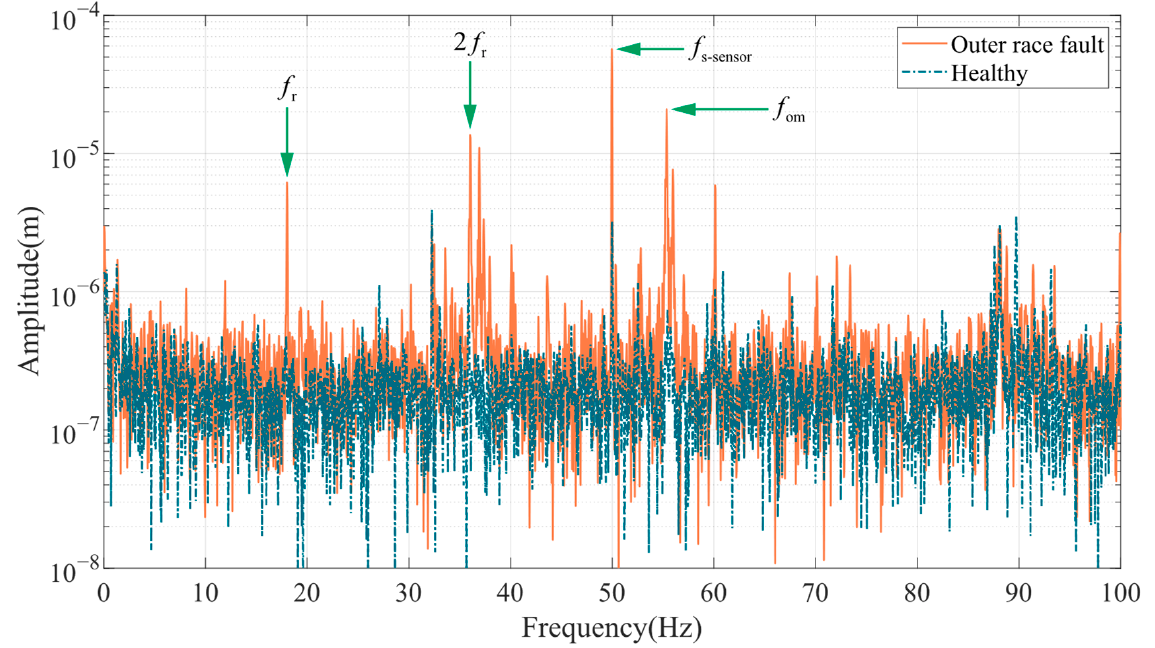
Figure 23. Comparison of vibration experiment signal spectrum of motor end cap under outer race fault (20 Hz).